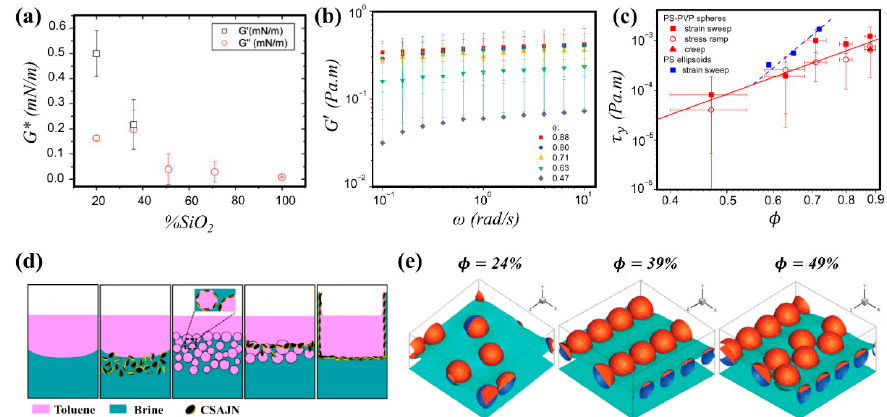
Figure 7. (Color online) Examples of shear rheology response for particle-laden fluid interfaces. ( a ) Impact of particle wettability, varied with altering the amount of silanol groups on the silica particle surface, on the complex interfacial shear modulus ( G ∗ ); ( b ) dependence of the elastic shear modulus ( G (cid:48) ) on frequency of oscillations and surface coverage, a higher coverage yields a more elastic behavior; ( c ) comparison between the yield stress of interfaces decorated with spheres (red symbol) and ellipsoids (blue solid symbol) as a function of the surface coverage; ( d ) formation of CSAJN Pickering emulsion in toluene and brine systems and the interfacial stability provided due to the interfacial film formation and climbing process; ( e ) shear-induced orientation and chaining of Janus particles at fluid interfaces simulated at different surface coverages. Panel ( a ) reprinted with permission from [102], copyright 2021 American Chemical Society. Panels ( b , c ) reprinted from [98]. Panel ( d ) reprinted from [90] with permission from Elsevier. Panel ( e ) reprinted with permission from [258], copyright 2021 by the American Physical